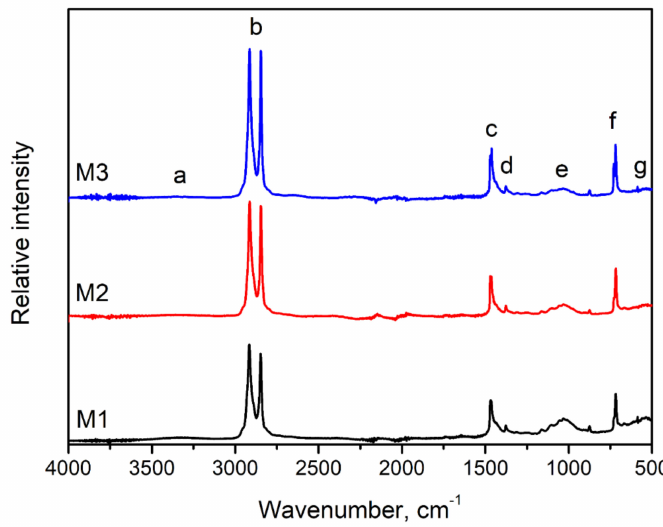
Figure 4. Fourier-transform infrared spectra of analyzed wastes (letters a–g indicate the particular signals described in the